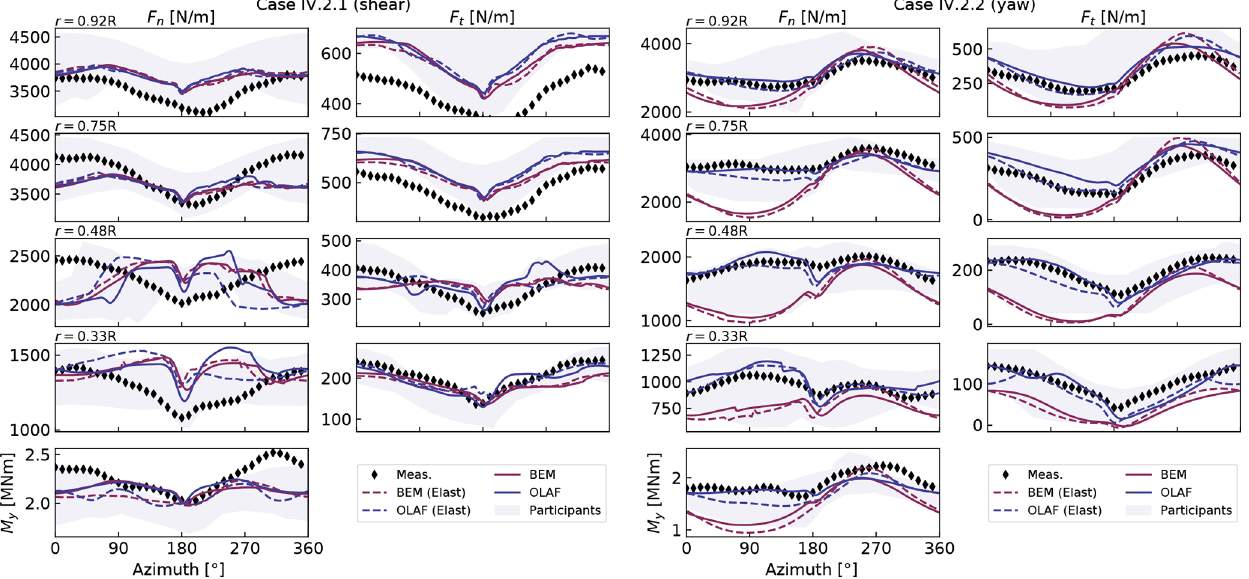
Figure 6. Results for a HAWT (NM 80) under strong shear (left) and yawed (right) conditions. The normal ( F n ) and tangential ( F t ) loads are shown at four radial positions as a function of the azimuth. The blade root flapping moment, M y , is shown at the bottom. Elastic (“Elast”) and rigid simulations are compared to the DanAero